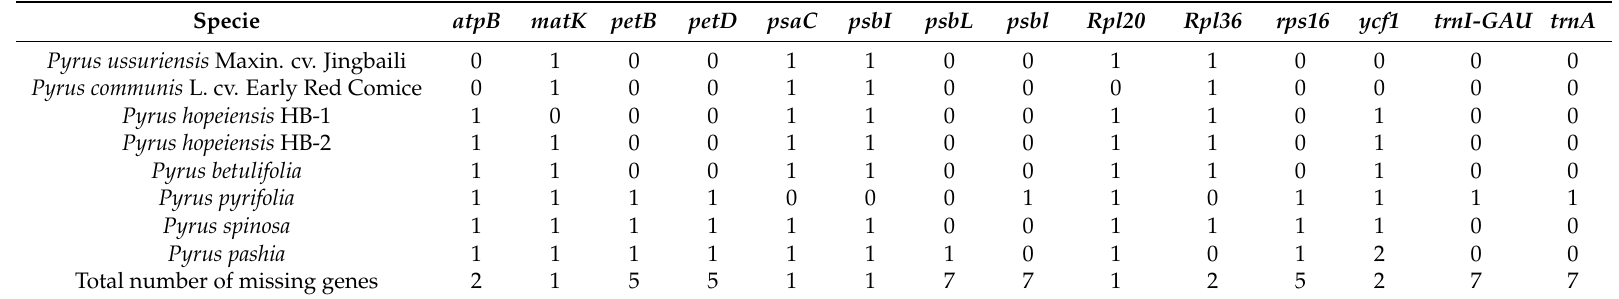
Table 4. Genes from the chloroplast genomes of Pyrus .